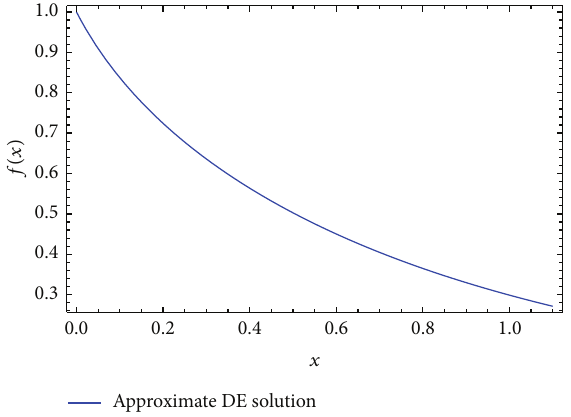
Figure 6: Approximate solution for 𝑦 󸀠 + 𝑦 4 + 𝑦 = 0 with 𝑦(0) = 1 .